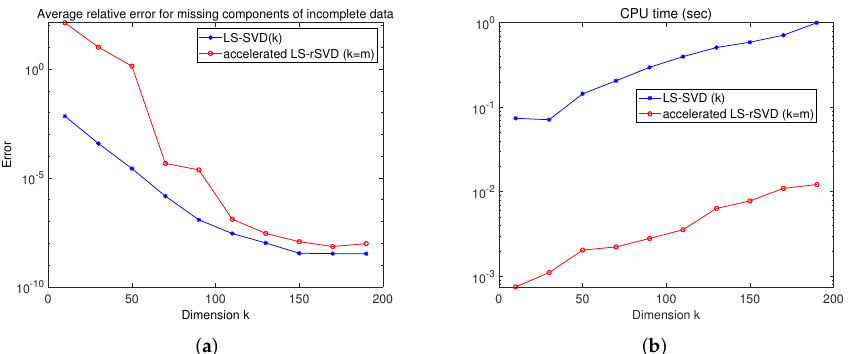
Figure 10. (Numerical Test 3) Reconstruction error ( a ) and CPU time ( b ) of the incomplete image from the standard least-squares approach and from the accelerated least-squares approach case (i) in Algorithm 4 using different dimensions of k and m = k